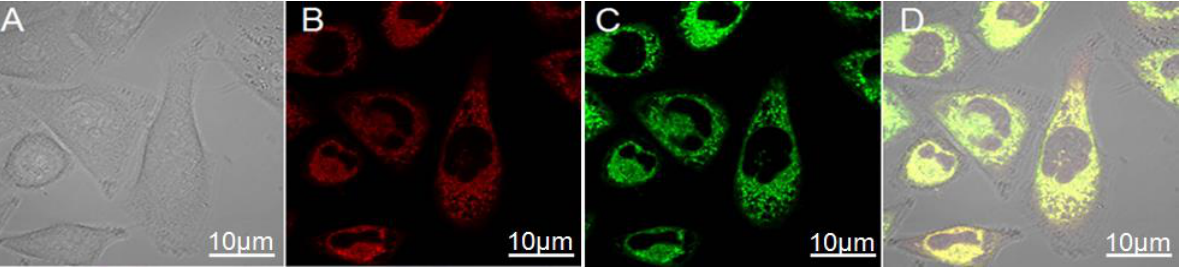
Figure 2. Morphology and cell viability of hADSCs from subcutaneous fat tissue cultured in vitro . Single adipose-derived stem cells (ADSCs) at passage 7 ( A ); mitochondria ( B ) of single ADSC stained by MitoTracker ® Red CMXRos; cellular nucleus ( C ) of single ADSC stained by SYTO ® green fluorescent nucleic acid stains; overlay ( D ) of ( C ) and ( D ). A – D :